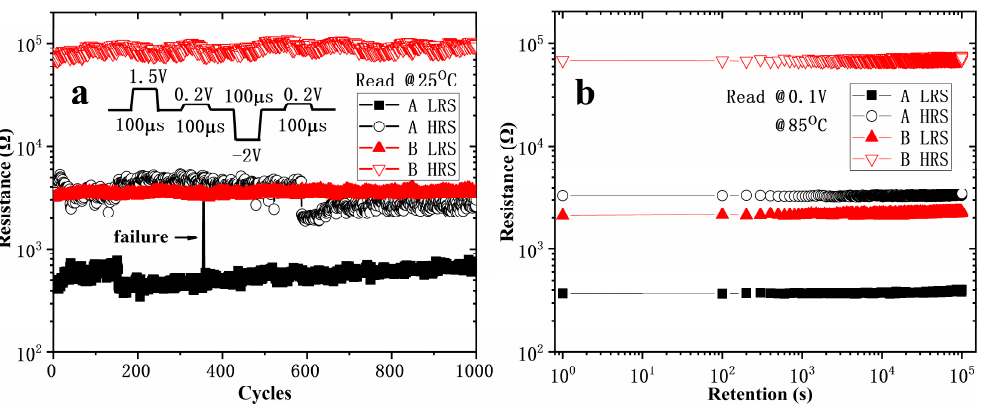
Figure 4. Cycling endurance ( a ) and data retention ( b ) at 85 °C for Device A and B. The area of the devices is 2 × 2 μ m 2 and the thickness of HfO x is 10 nm.